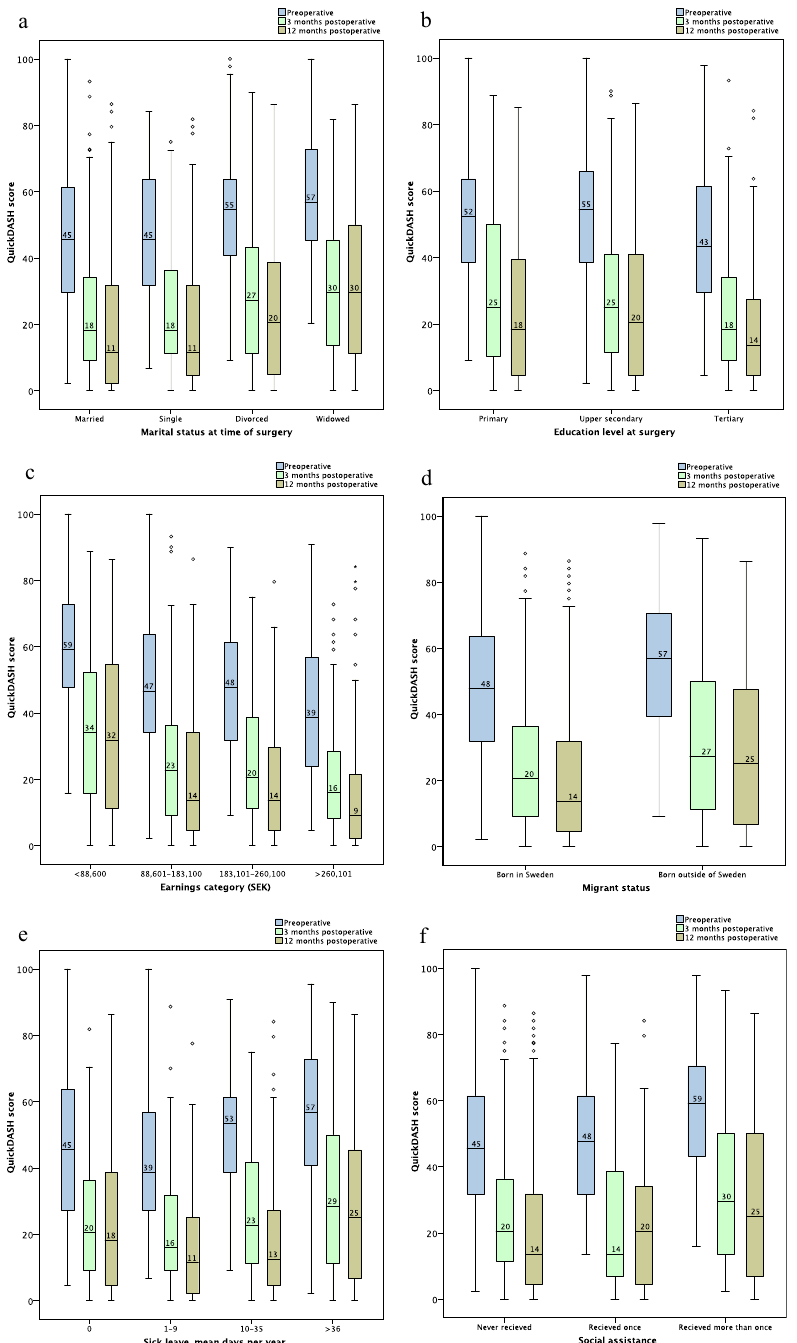
Figure 1. QuickDASH scores. ( a ) Groups based on marital status. ( b ) Groups based on education level. ( c ) Groups based on earning category (mean earnings per year between 20 and 70 years of age). ( d ) Groups based on migrant status. ( e ) Groups based on mean sick leave days per year. ( f ) Groups based on social